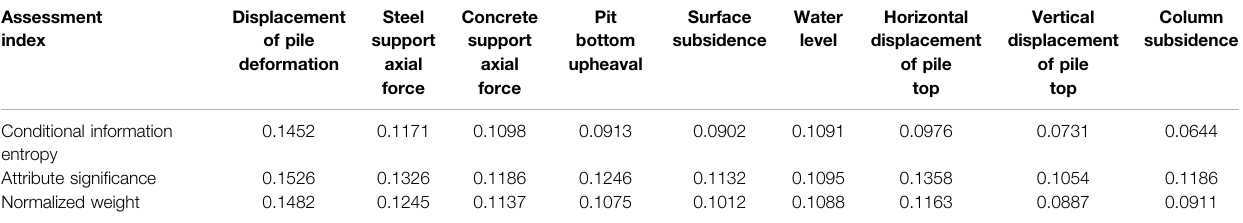
TABLE 2 | Weight calculation.